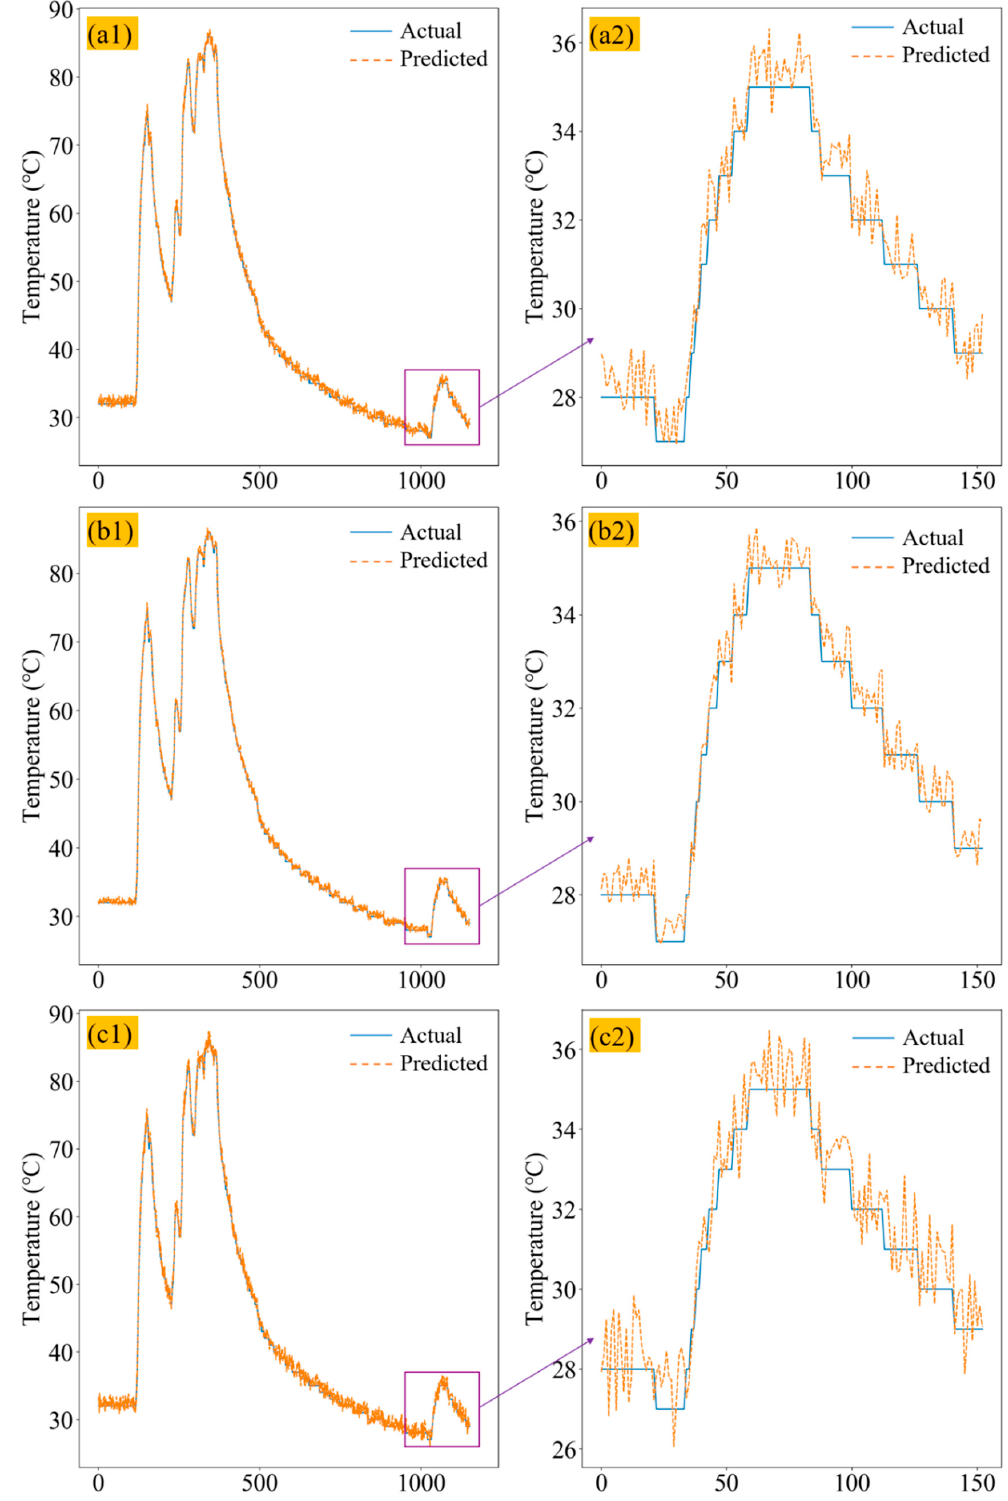
Figure 7. ( a1 ) The three-layer LSTM predicted axle box bearing temperature and actual axle box bearing temperature comparison curve. ( b1 ) The four-layer LSTM predicted axle box bearing temperature and actual axle box bearing temperature comparison curve. ( c1 ) The five-layer LSTM predicted axle box bearing temperature and actual axle box bearing temperature comparison curves. ( a2 ), ( b2 ), and ( c2 ) are their local enlarged drawings.